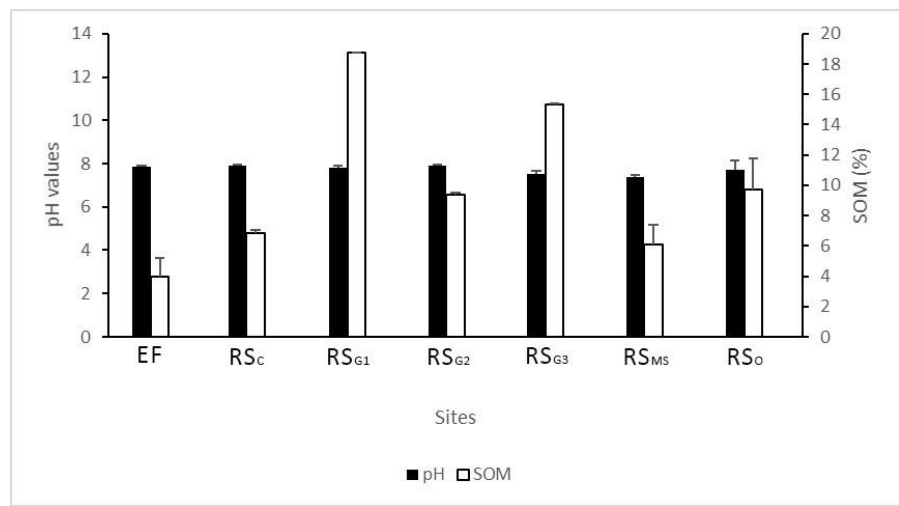
Figure 4. Average and standard error of the pH and SOM found in each site.